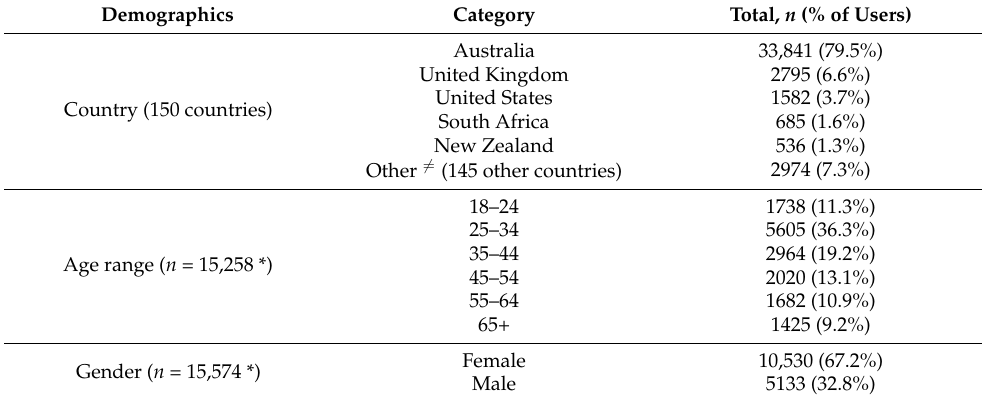
Table 3. Demographics of new